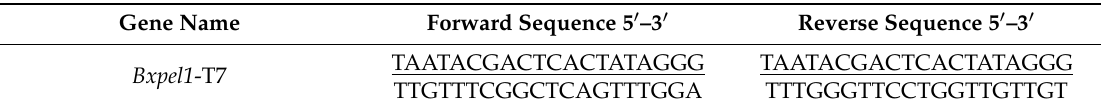
Table 2. PCR primers for the Bxpel1 gene in B. xylophilus . The underlined primers are the sequences of T7 promotor.